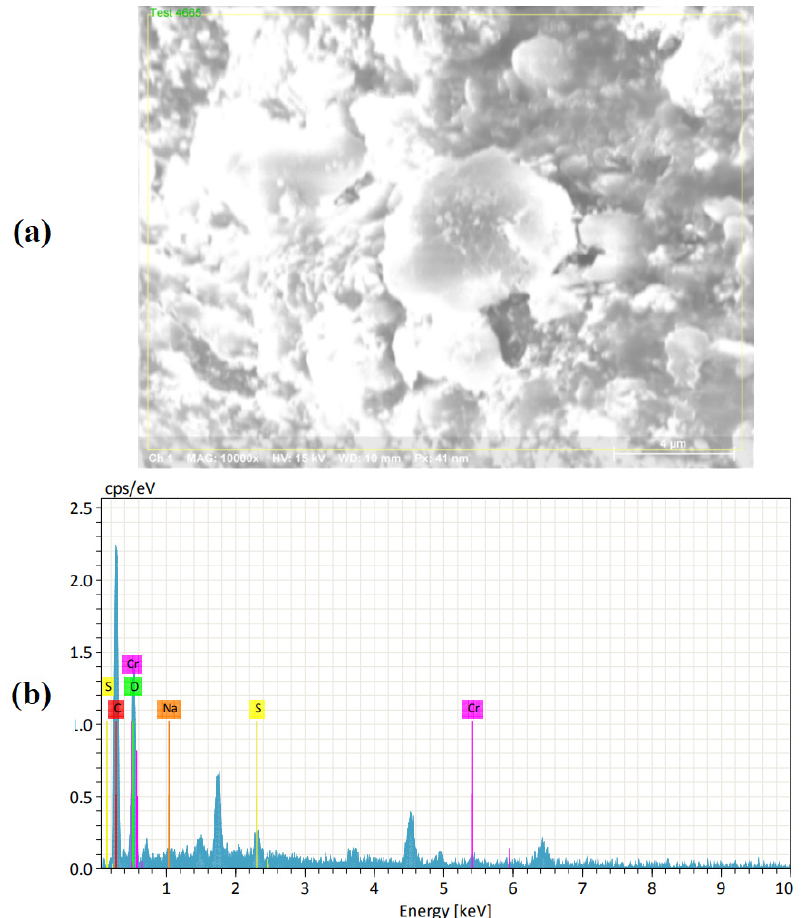
Table 3. Elemental analysis of laser-machined leather.